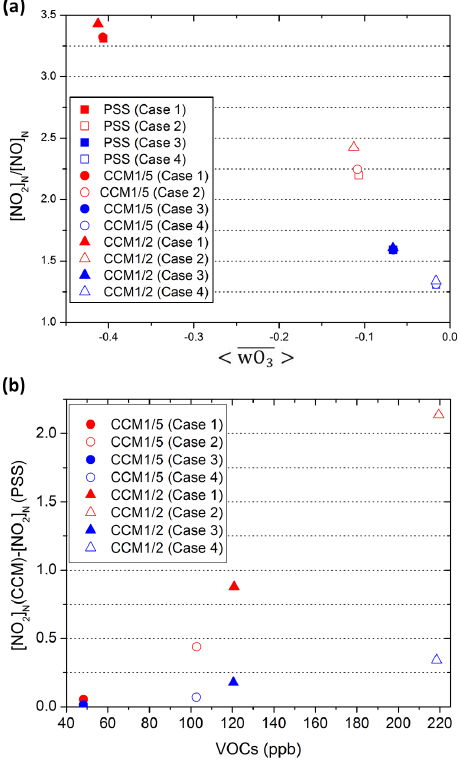
Figure 10. (a) The average concentration within the canopy of [NO 2 ] N / [NO] N against the total flux of O 3 at roof level and (b) the variation of the average concentration within the canopy of [NO 2 ] N with CCM1/5 and CCM1/2 from that the PSS over the average con- centration of